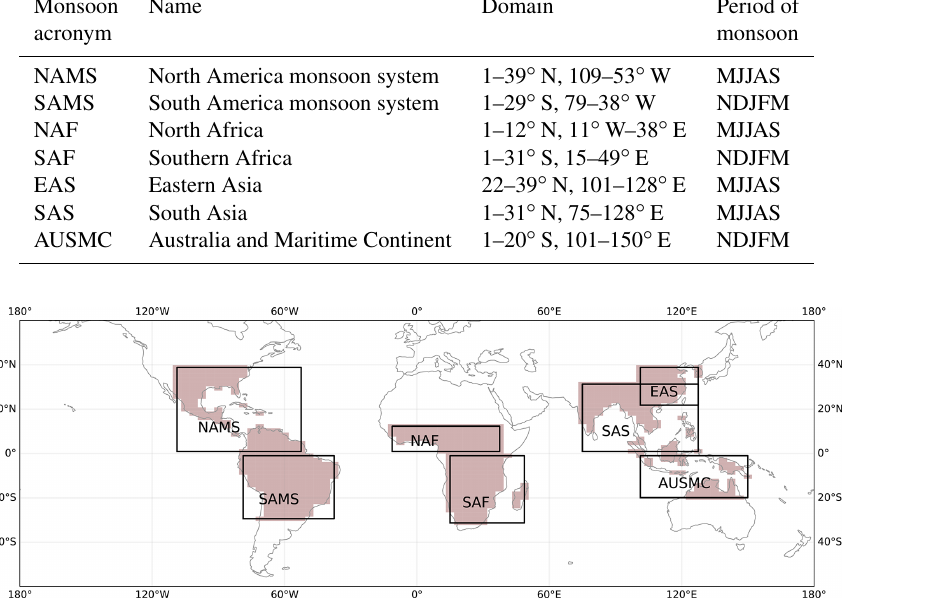
Figure 1. Regions used in this study. See Table 1 and the Methods section for more